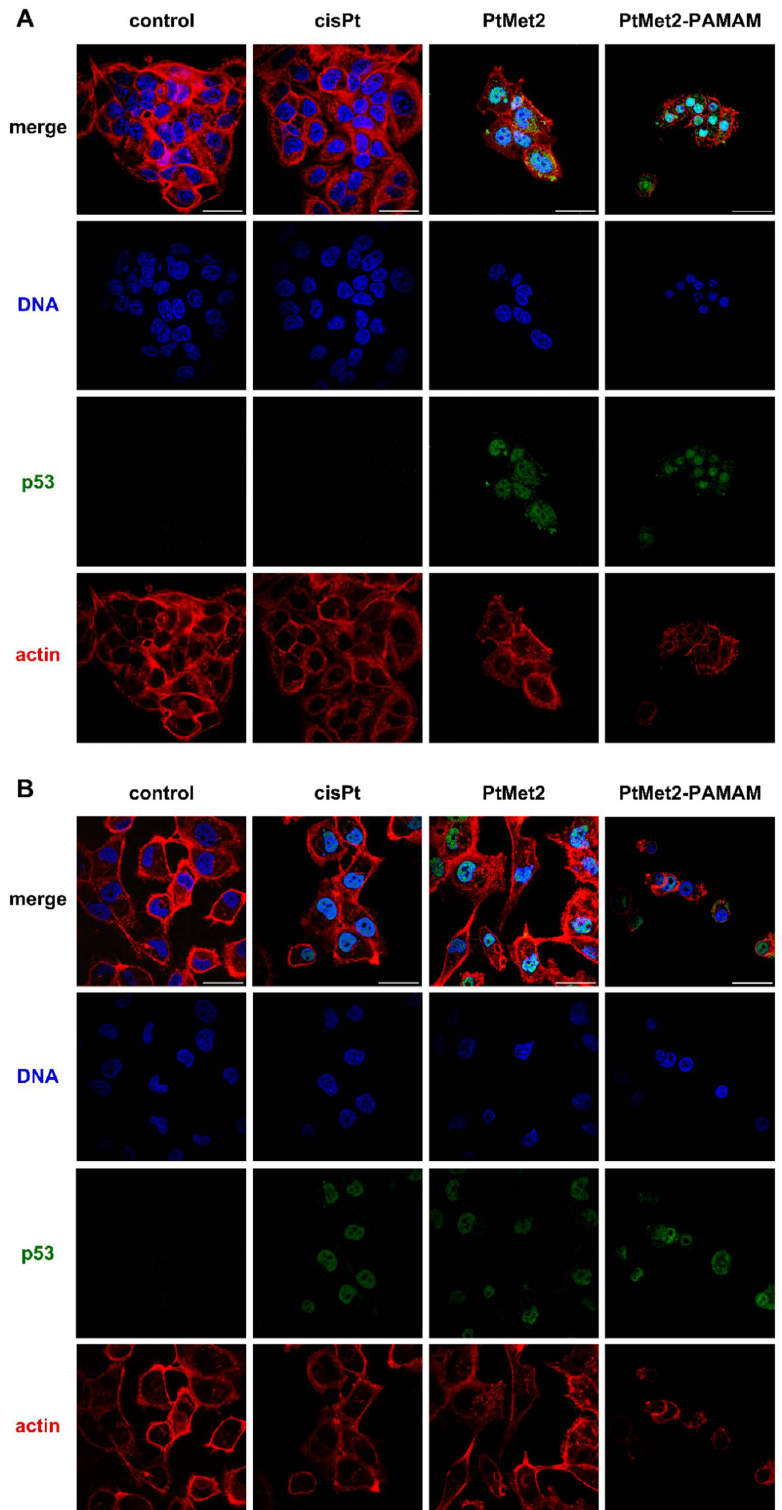
Figure 16. Confocal micrographs of MCF-7 ( A ) and MDA-MB-231 ( B ) breast cancer cells treated with PtMet2, PtMet2–PAMAM, and cisplatin (2.5 μM all of them, incubation time 24 h). For each panel, the images from bottom to top show actin filaments, p53, DNA, and overlays of the four images, scale bar 50 μm.